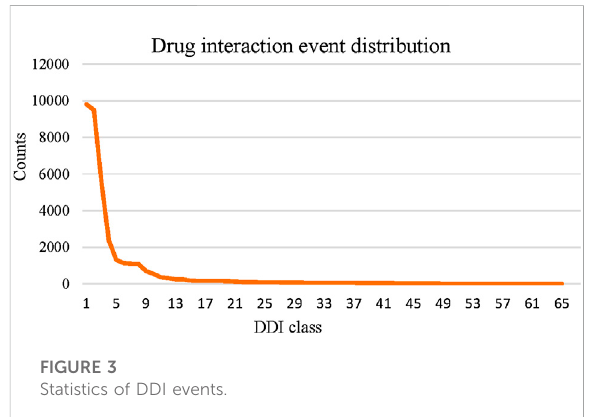
FIGURE 3 Statistics of DDI events.